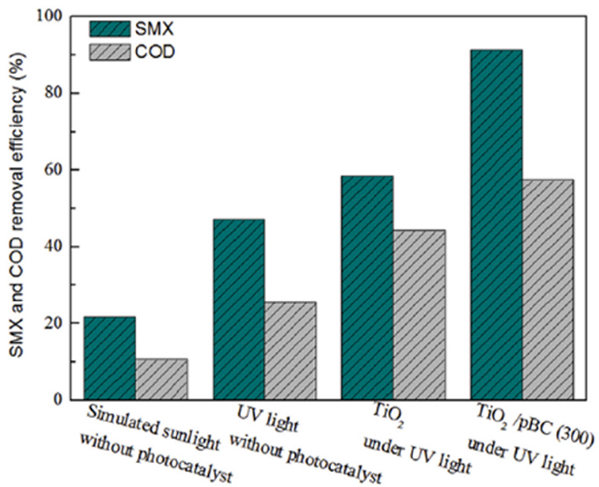
Figure 9. Photochemical degradation of SMX and COD under sunlight and UV light using TiO 2 /pBC composite (Initial SMX concentration = 10 mg/L, Photocatalyst dose = 0.2 g) (Reproduced from [88] Copyright Year 2017, Chemosphere with the permission License number: 5141190415626).